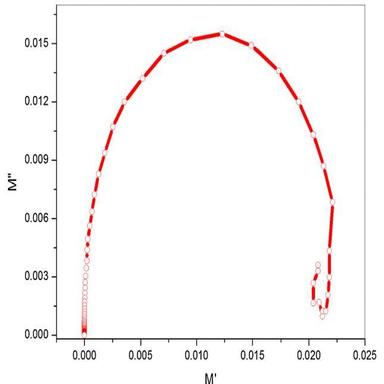
Complex electric modulus M″ versus M′ plot of PCOH at room temperature.